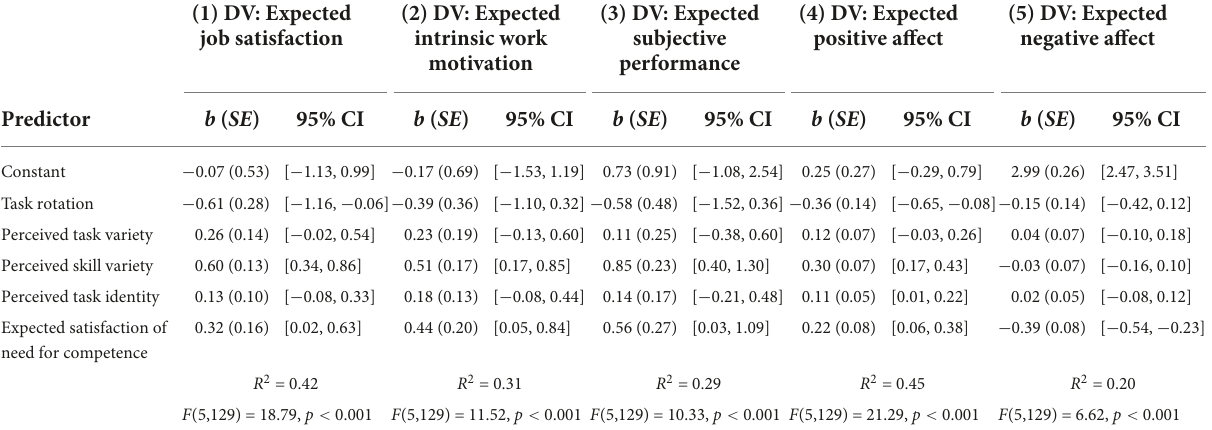
TABLE 5 Regression coefficients, standard errors, and model summary for all outcomes in Study